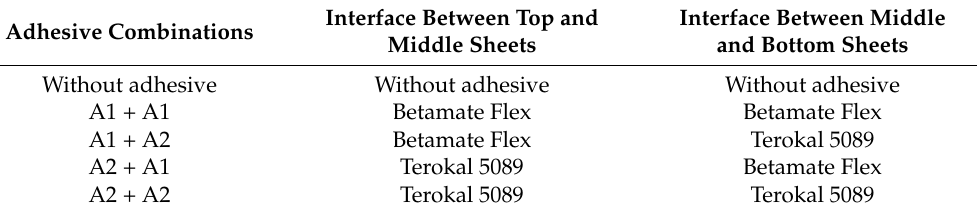
Figure 14. The cross-sections of the weld size in different times for different adhesive types. ( a ) 220 ms; ( b ) 420 ms. Table 4. Adhesive combinations with Betamate Flex and Terokal 5089.